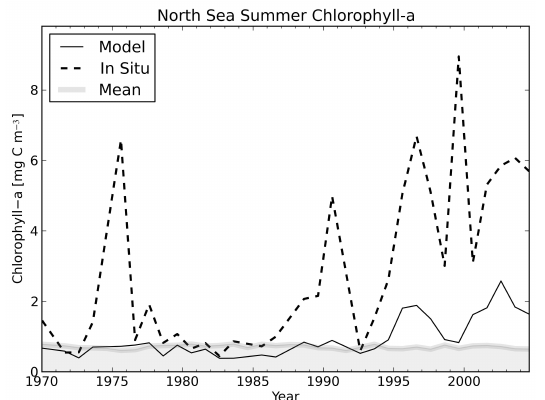
Fig. 16. North Sea mean spring chlorophyll time series: the black line is the matched model mean spring chlorophyll, the dashed line the mean spring in situ chlorophyll, and the grey area shows the MLD-averaged mean chlorophyll of the North Sea.